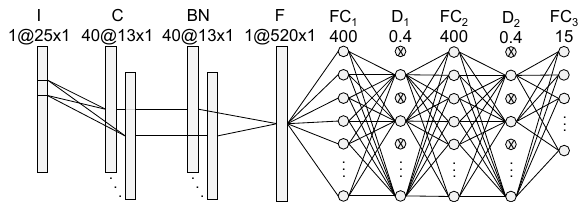
Figure 3. Architecture of the proposed CNN for Cubert data classification.